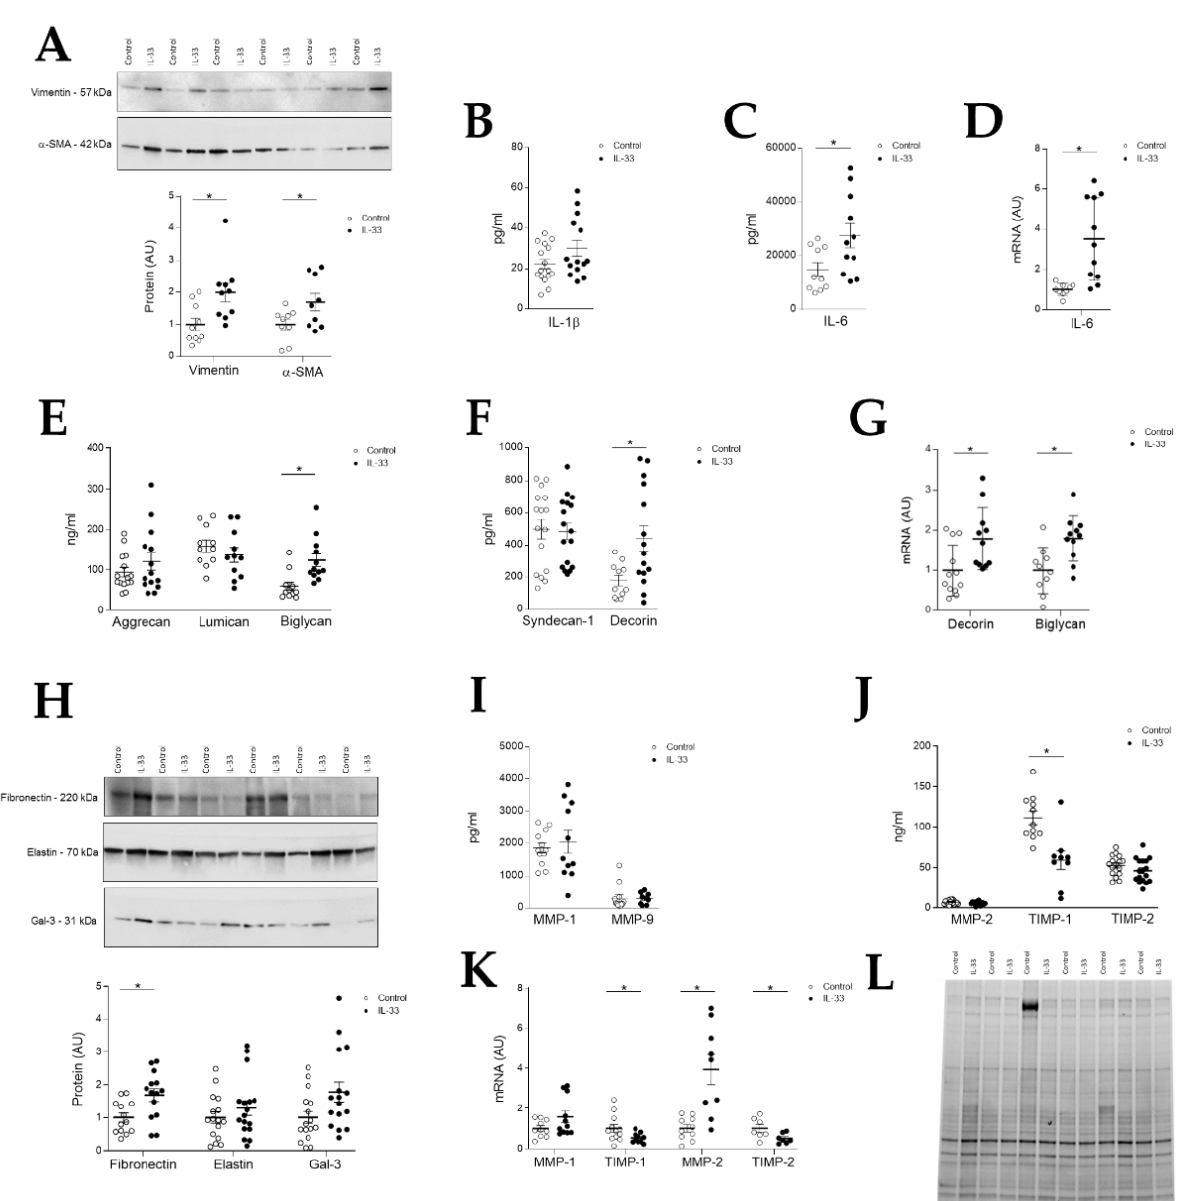
Figure 3. Effects of IL-33 on human mitral VICs. ( A ) Quantification of VICs activation markers (vimentin and α -SMA) in VICs treated with IL-33; ( B , C ) Quantification of secreted inflammatory markers (IL-1 β and IL-6) in VICs treated with IL-33; ( D ) Quantification of mRNA of IL-6 in VICs treated with IL-33; ( E ) Quantification of extracellular proteoglycans aggrecan, lumican and biglycan in VICs treated with IL-33; ( F ) Quantification of secreted proteoglycans syndecan-1 and decorin in VICs treated with IL-33; ( G ) Quantification of mRNA of decorin and biglycan in VICs treated with IL-33; ( H ) Quantification of fibronectin, elastin and Galectin-3 at protein levels in VICs treated with IL-33; ( I ) Quantification of secreted MMP-1 and MMP-9, ( J ) TIMP-1, MMP-2, TIMP-2 at protein levels in VICs treated with IL-33; ( K ) Quantification of mRNA of MMP-1, TIMP-1, MMP-2 and TIMP-2 in VICs treated with IL-33; ( L ) Representative Stain free. Box plots show the individual datapoints and the horizontal bars indicate the mean and SEM in arbitrary units versus the control group. For Western blot experiments, protein densitometry was expressed in arbitrary units (AU) once normalized to stain-free and β -actin. Representative blots have been displayed when appropriate. * p < 0.05 vs. control. IL-33: α -SMA: Alpha-smooth muscle actin; IL: Interleukin; Gal-3: Galectin-3; MMP: Matrix metalloproteinase; TIMP: Tissue inhibitor of